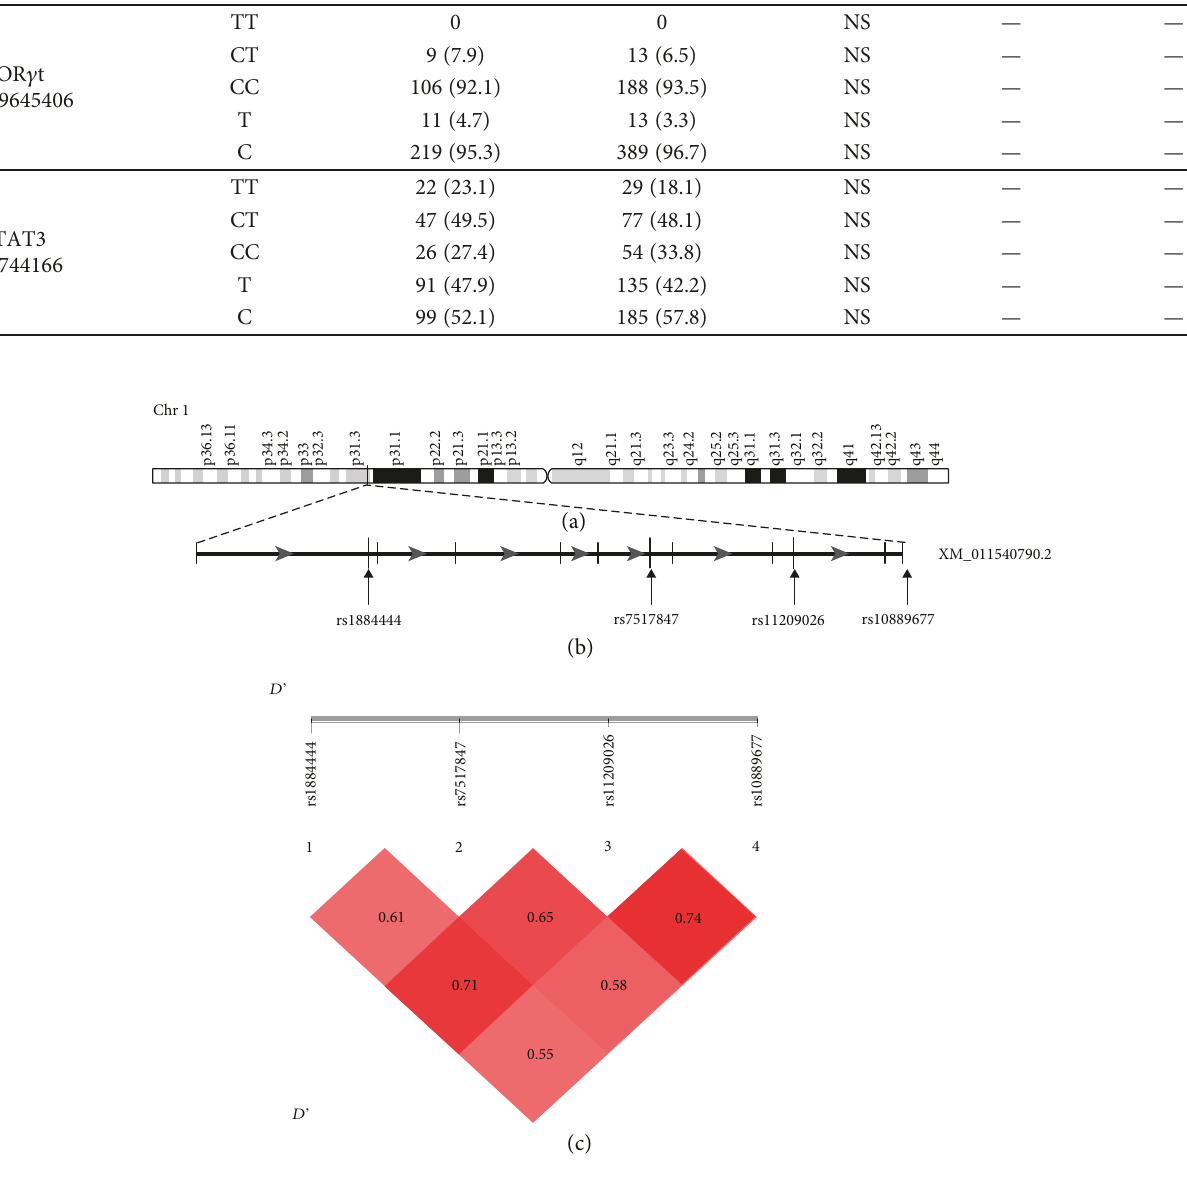
Figure 1: Overview and linkage disequilibrium (LD) on chromosome 1q31.1. (a) Overview of chromosome 1. (b) Schematic structure of the IL23R gene. Exons are depicted by black vertical lines. The positions of the four SNPs are shown by the arrows. (c) LD prime charts generated using SHEsis software summarize LD ( D ’ ) patterns between the 4 SNP. D ’ > 0.7 is considered as a high value of LD.